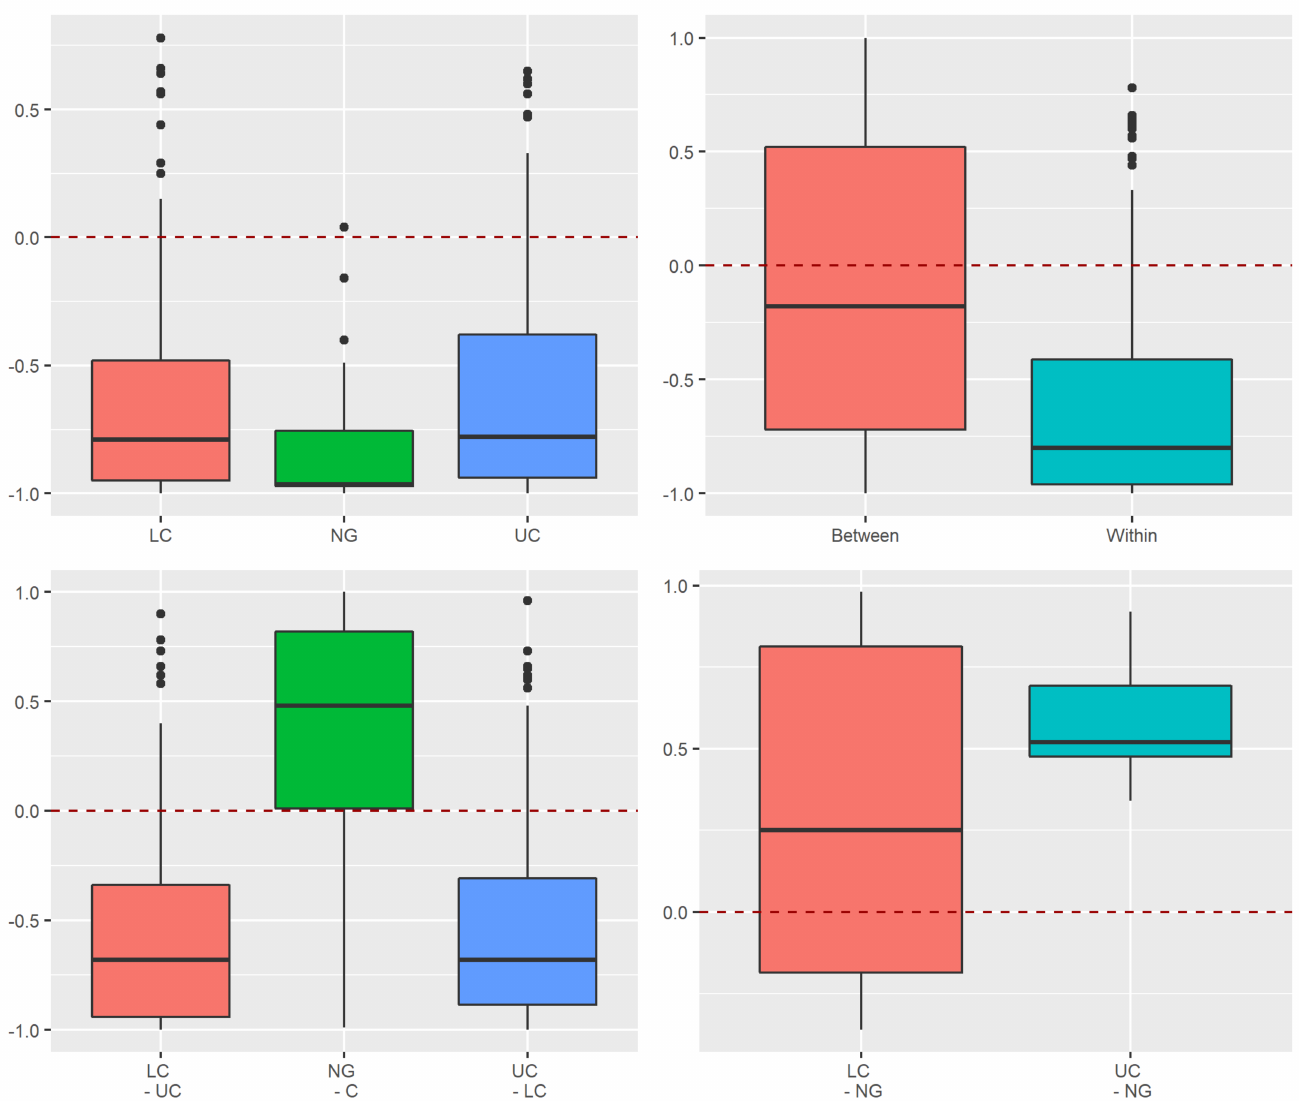
Figure A3. Deviation of the beta diversity from the diversity expected by the null hypothesis per stratum for the rare beetle species. NG—near-ground stratum, LC—lower canopy, UC—upper canopy. Comparisons within a stratum are comparisons of two traps of the same stratum. Comparisons between strata are comparisons of two traps from two different